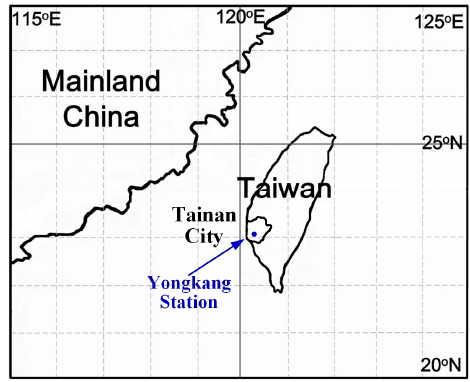
Figure 1. Location of the study site.